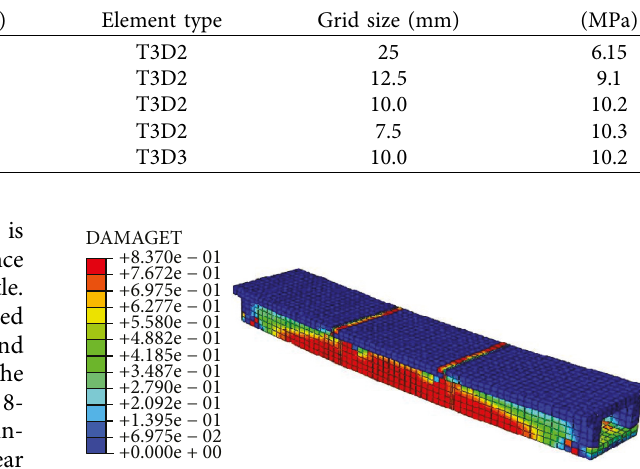
Figure 8: Nephogram of tensile damage of test beam.